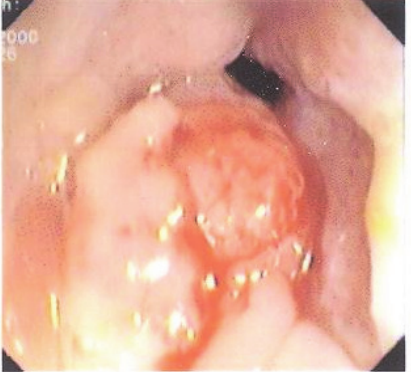
Figure 3: Tumoral mass in rectum (case 2).